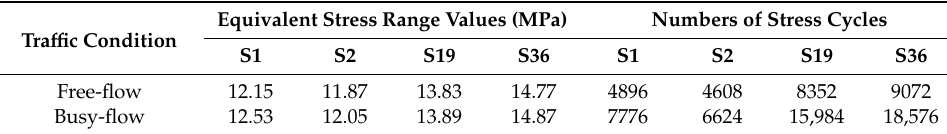
Table 7. Stress ranges and number of stress cycles due to traffic load in one day.